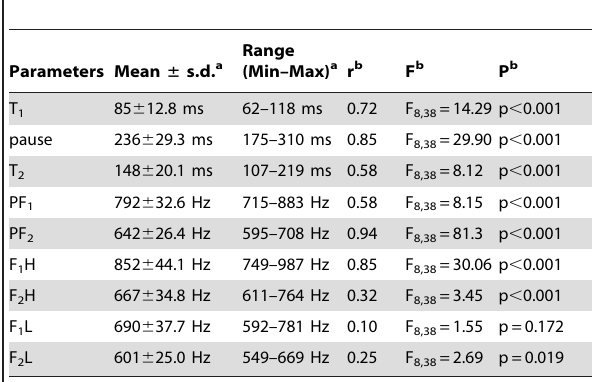
Table 1. The range of 9 call parameters and its consistency measured by calculating repeatability (r).